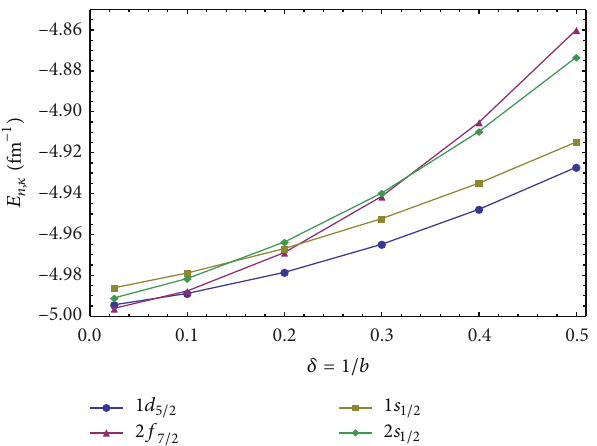
Figure 9: The variation of the energy spectrum 𝐸 𝑛,𝑘 for tensor Coulomb potential in the case of p-spin symmetry according to the screening parameter 𝛿 . Here we selected 𝑈 0𝐶 = 0.1 , 𝛼 = 0.01